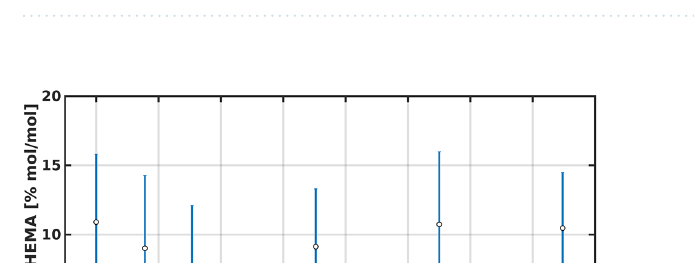
Figure 6. Response of poly(HEMA)